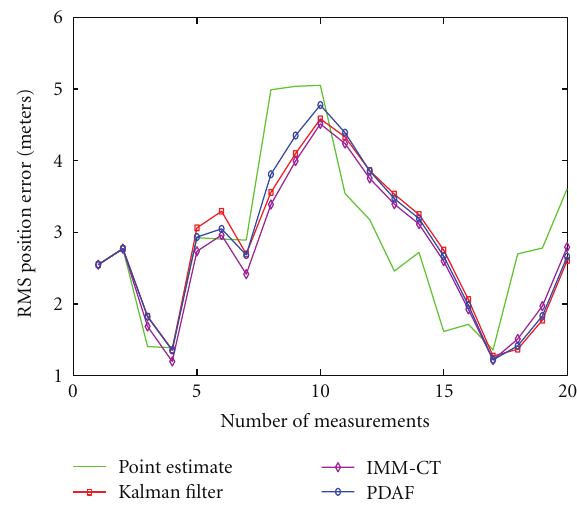
Figure 16: Localization error during second lake